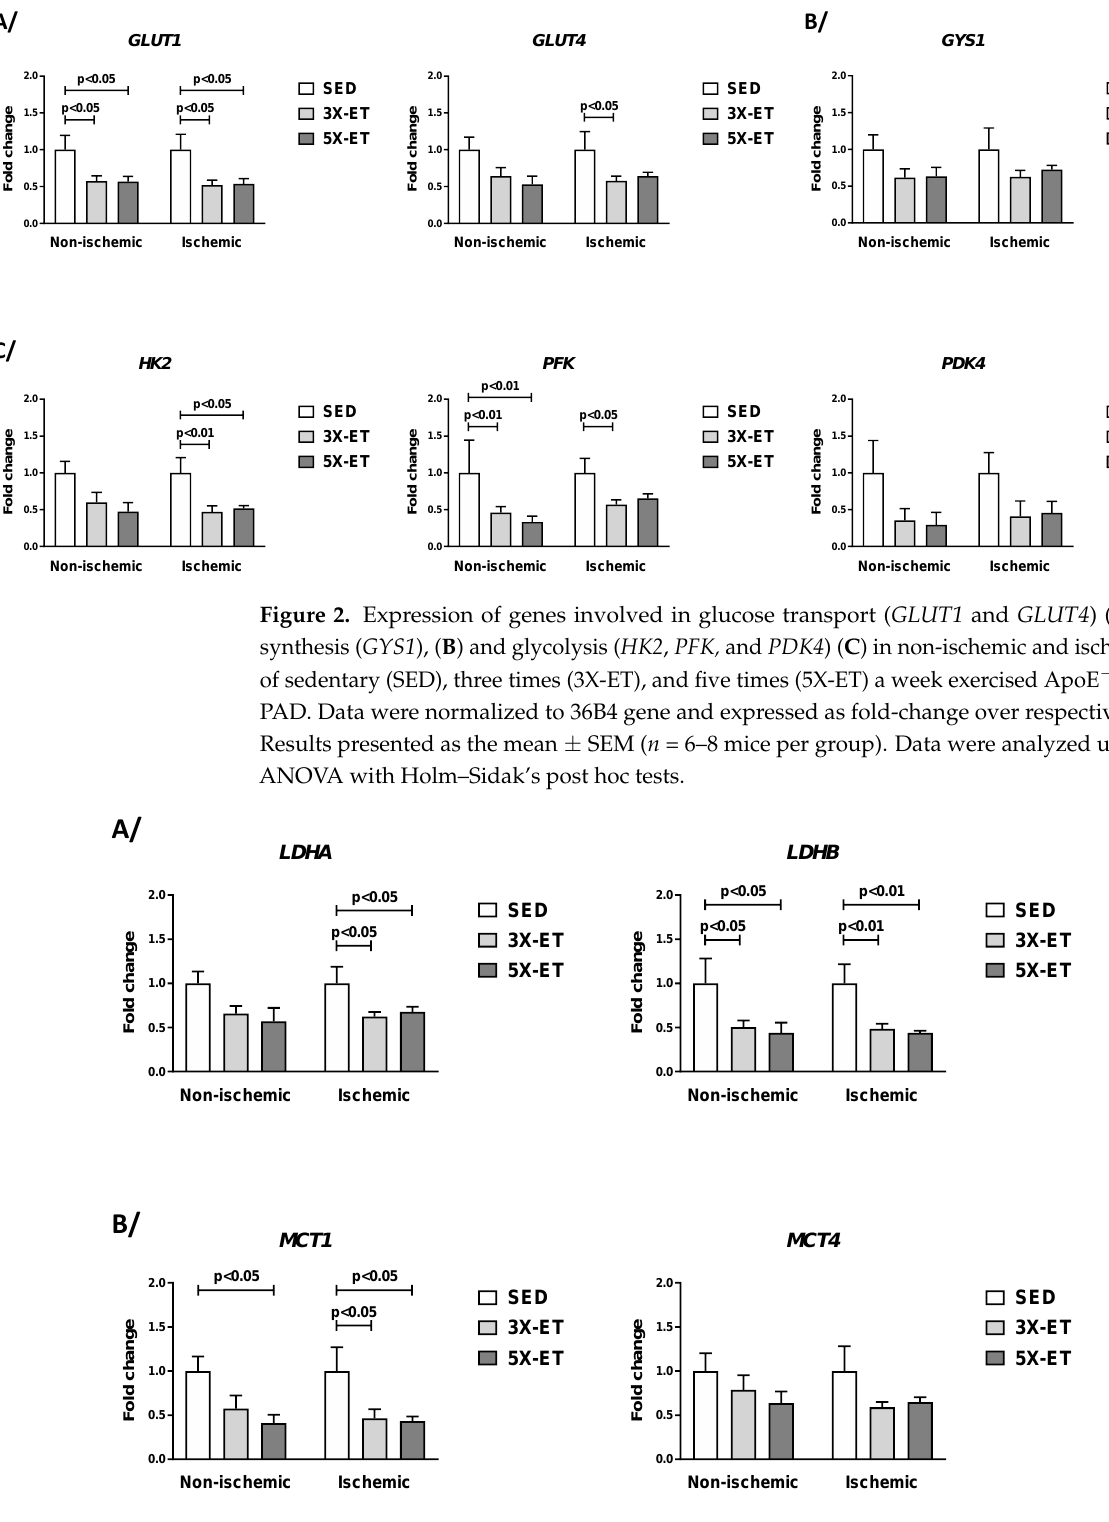
Figure 3. Expression of genes involved in lactate production ( LDHA and LDHB ) ( A ) and lactate transport ( MCT1 and MCT4 ) ( B ) in non-ischemic and ischemic muscles of sedentary (SED), three times (3X-ET), and five times (5X-ET) a week exercised ApoE −/− mice with PAD. Data were normalized to 36B4 gene and expressed as fold-change over respective SED group. Results presented as the mean ± SEM ( n = 6–8 mice per group). Data were analyzed using one-way ANOVA with Holm– Sidak’s post hoc tests.